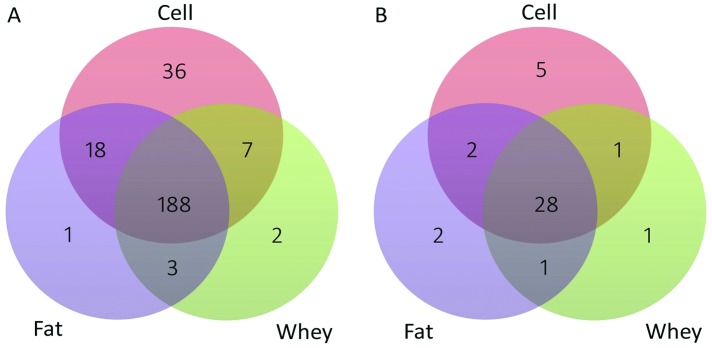
Venn diagrams showing the number of known (A) and novel miRNAs (B) identified in milk fractions as well as miRNAs unique to each fraction or common to two or all three fractions.